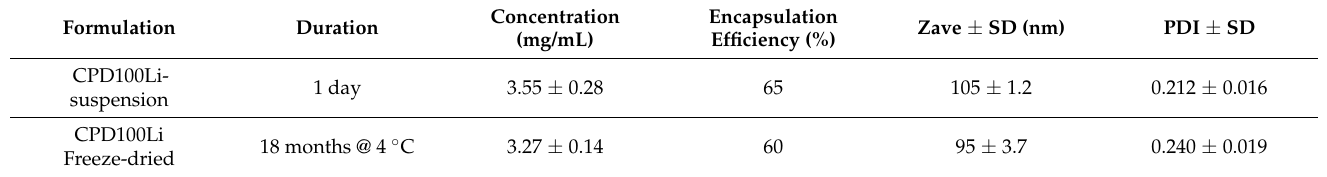
Table 1. The long-term stability of CPD100 liposomes prepared using the microfluidics